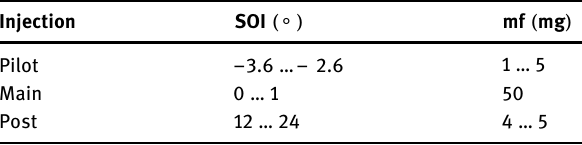
Table 1: Values of injections for each